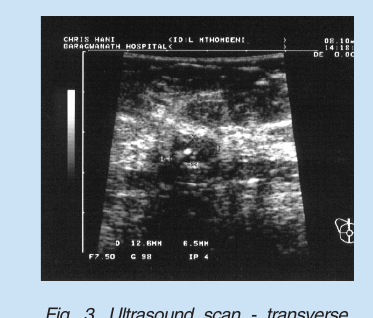
Fig. 3. Ultrasound scan - transverse image of the right breast showing ill- defined hypoechoic lesion and micro-